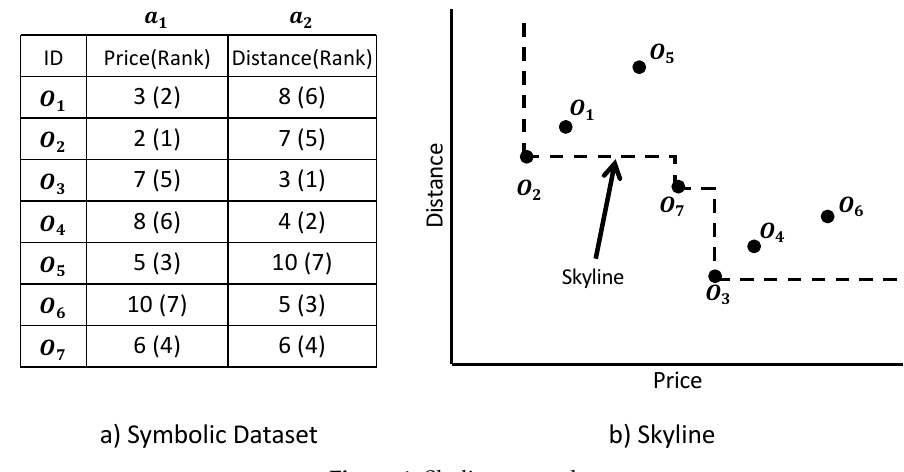
Figure 1. Skyline example.